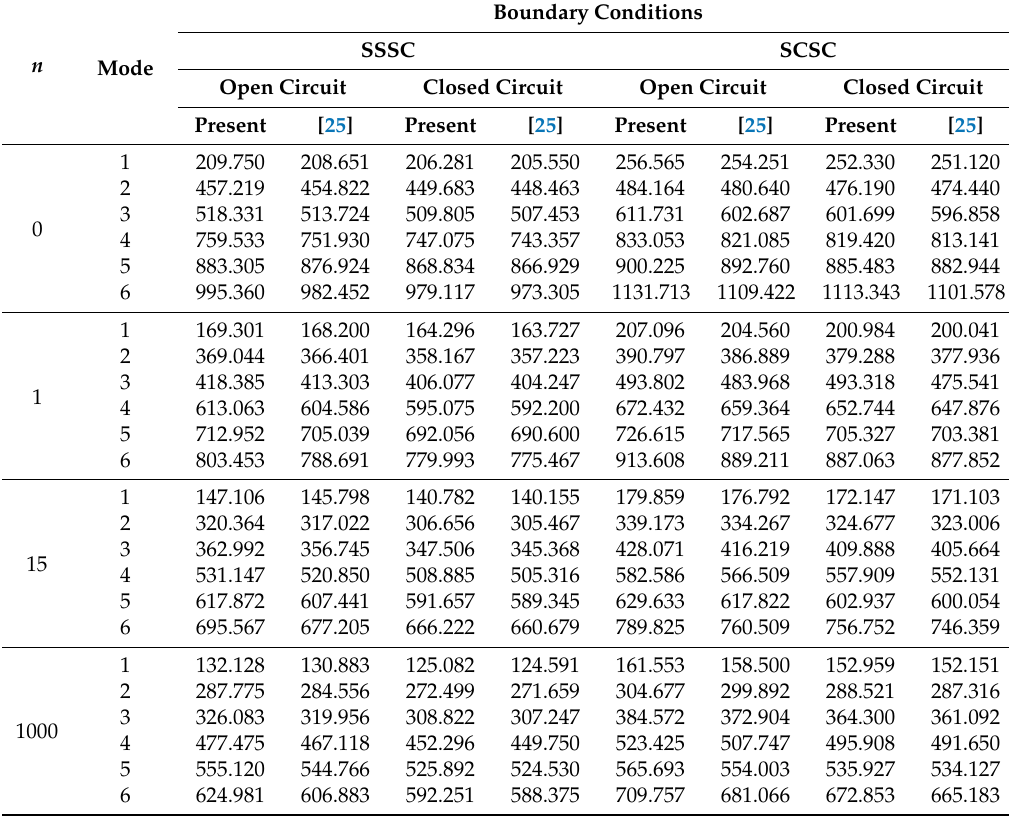
Table 4. The natural frequencies (Hz) of SSSC and SCSC